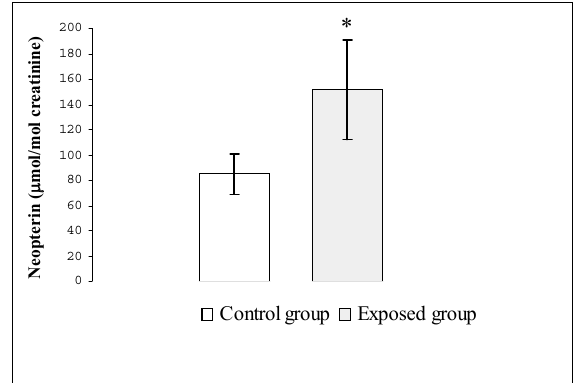
Figure 1. Urinary neopterin concentrations in controls (n = 30) and workers exposed to anesthetics (n = 40). * p < 0.05; compared to the control